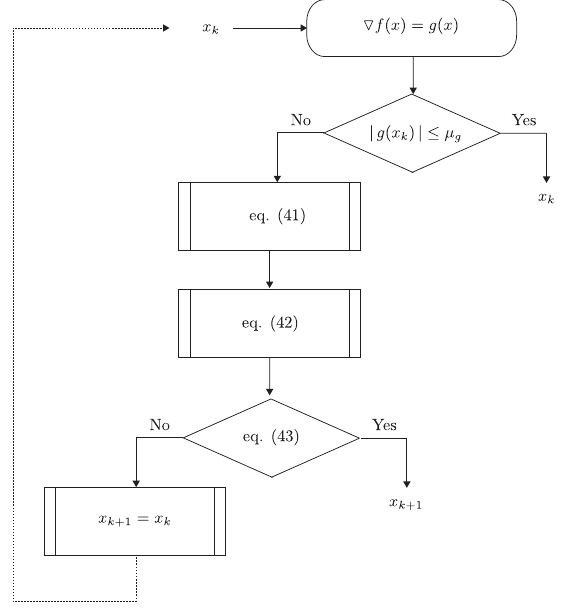
Figure 6. Gradient-based optimization algorithm